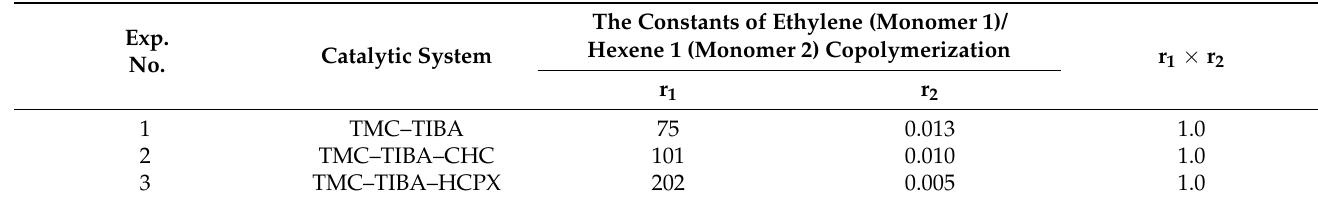
Table 4. The constants of ethylene/1-hexene copolymerization over TMC in the presence of COC in the catalyst. The conditions are listed in Table